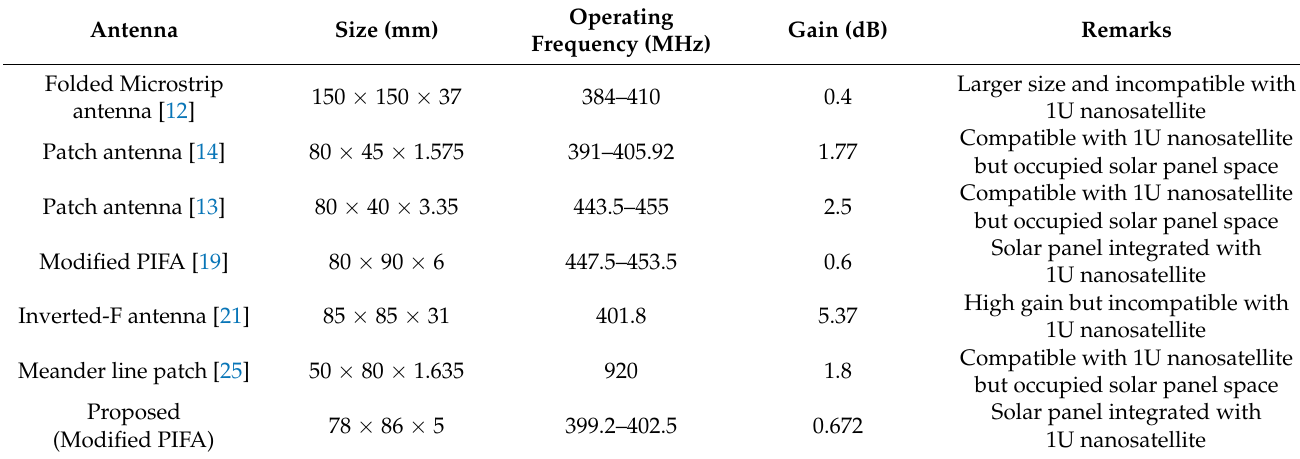
Table 3. Comparison between proposed antenna and existing lower UHF